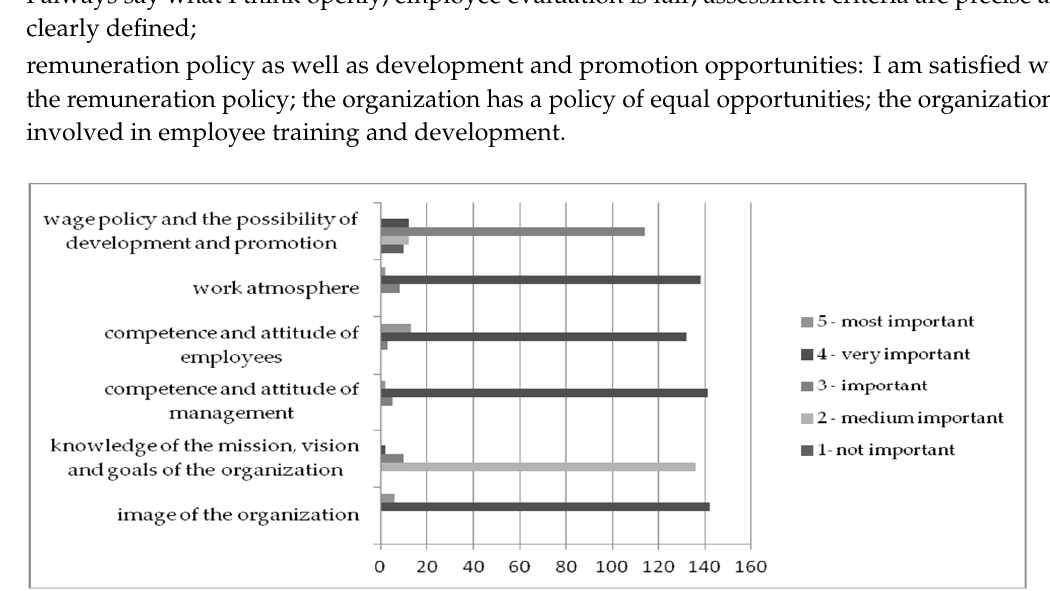
Figure 1. Organizational trust by respondents.